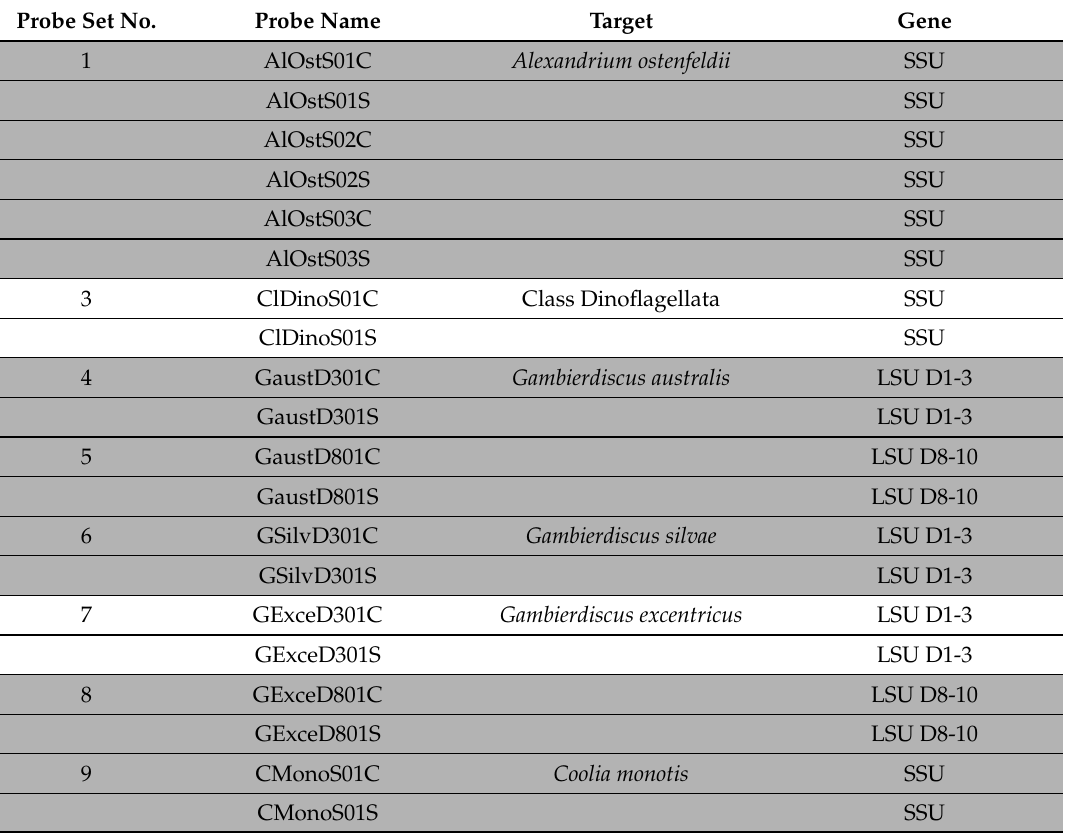
Table 1. List of probes designed EMERTOX and their target. Those marked in grey were tested here. C denotes the capture probe and S denotes the signal probe to detect the synthetic target. They were combined together as a single probe to detect RNA. Probe Set